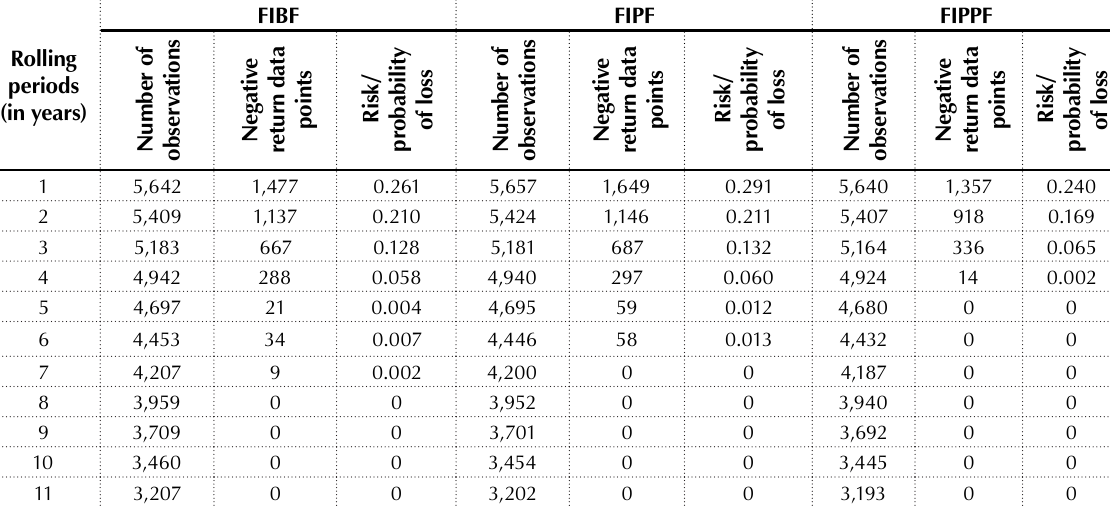
Table 12. Rolling period risk and return behavior of FIBF, FIPF and FIPPF